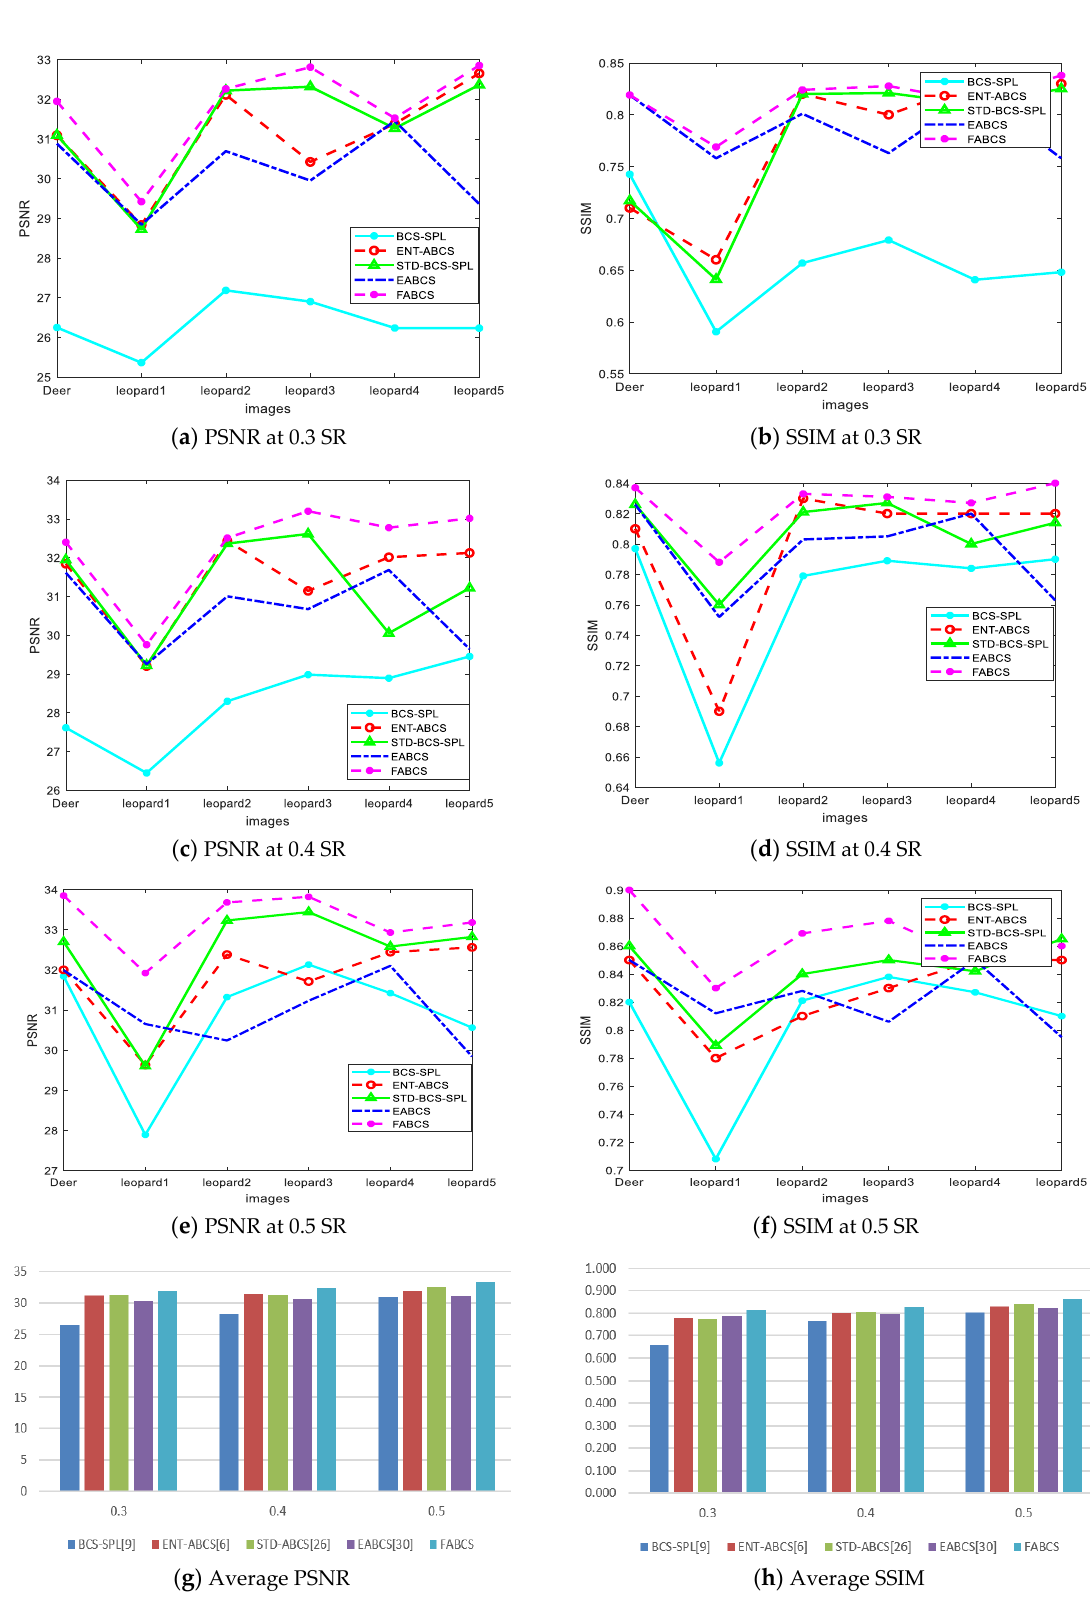
Figure 7. Performance comparison of different algorithms on CCTV images based on PSNR and SSIM.